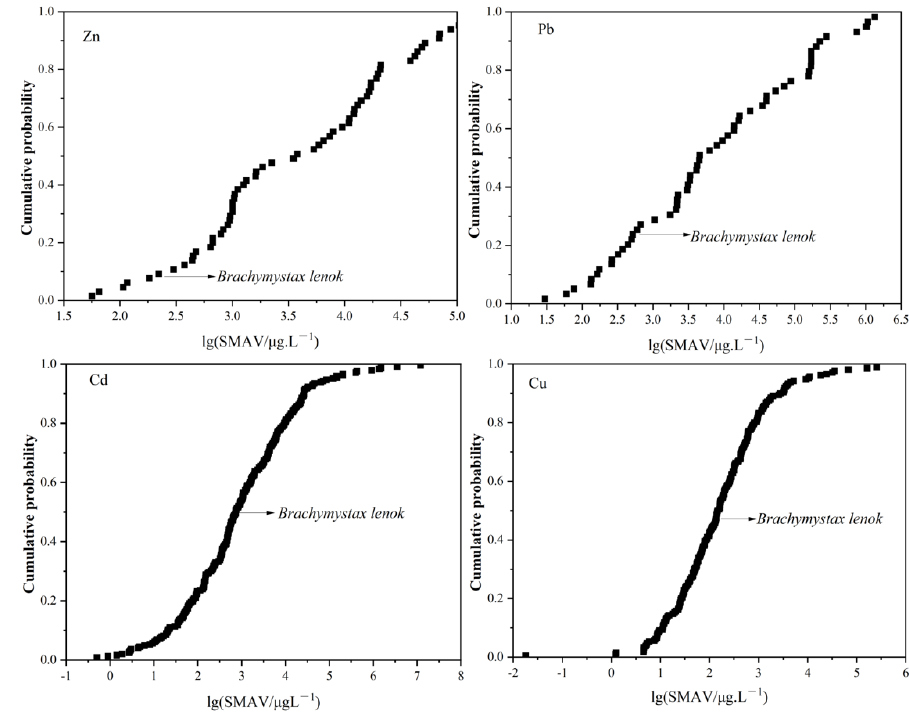
Figure 1. Species sensitivity distributions for the four heavy metals, across all available species. Table 2. The sensitivity analysis of B. lenok to four heavy metals in comparison to other species.